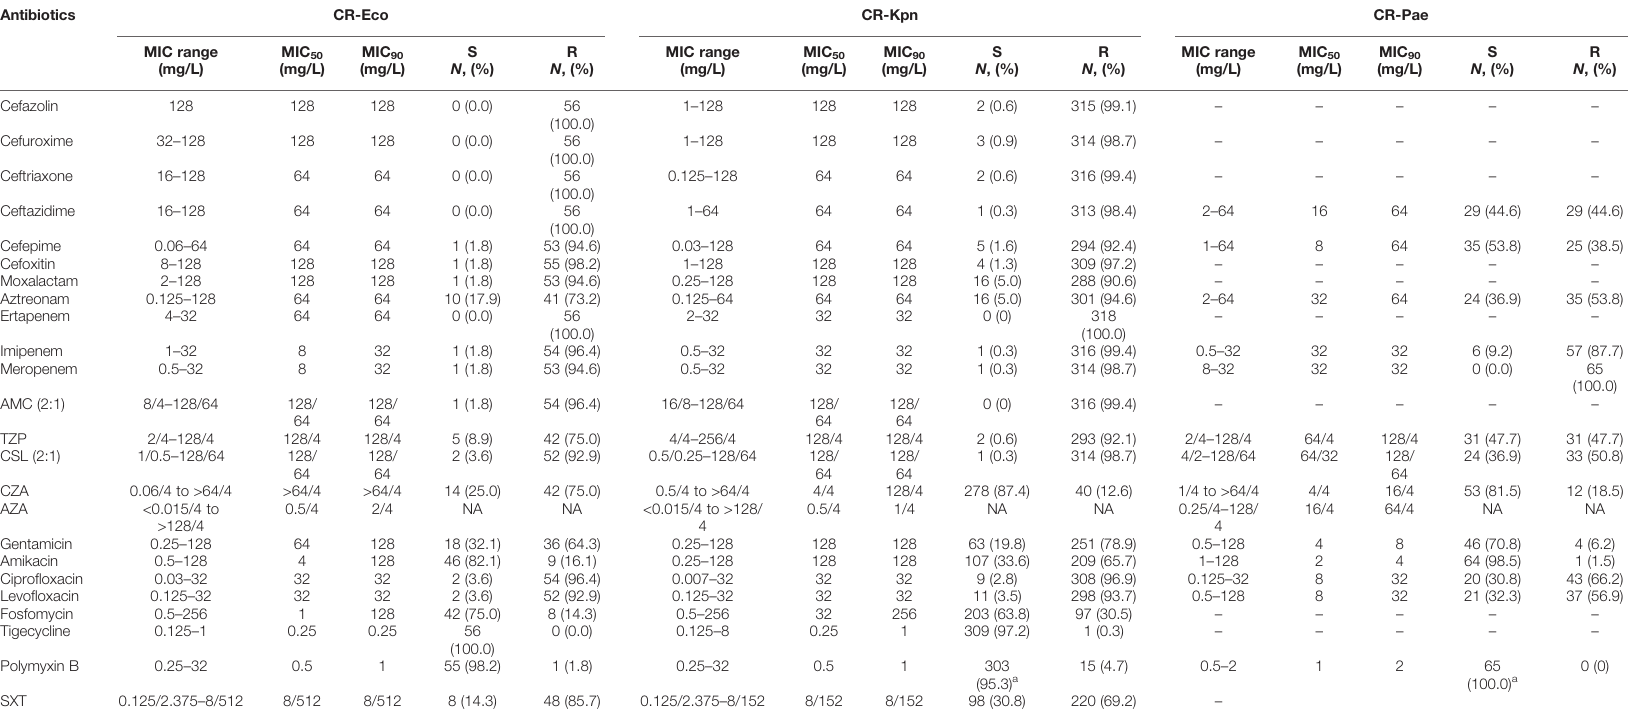
TABLE 1 | Antibiotic susceptibility test of the 24 antibiotics.